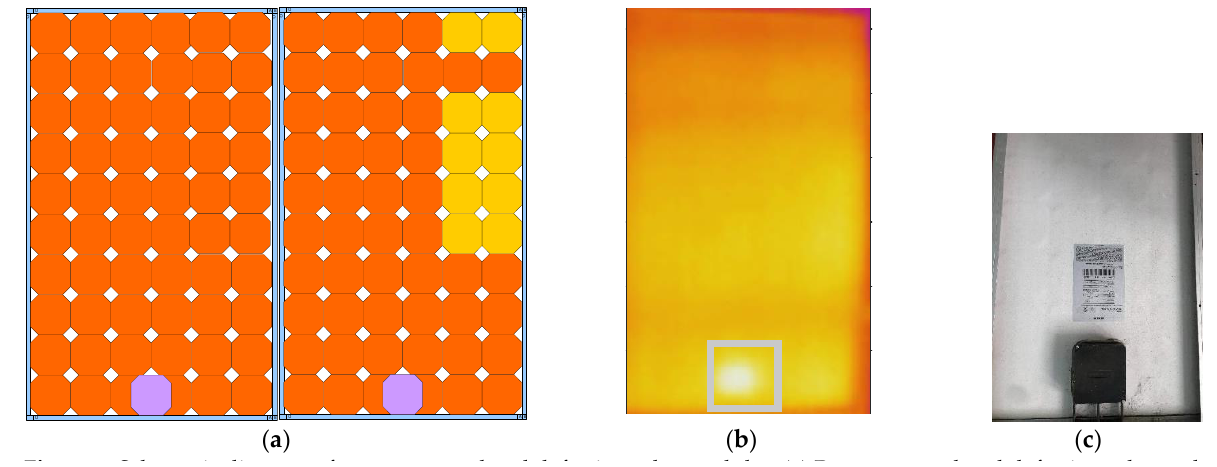
Figure 6. Schematic diagram of pre-set normal and defective solar modules . ( a ) Pre-set normal and defective solarmodules . ( b ) Junction box for the IR image . ( c ) Junction box .